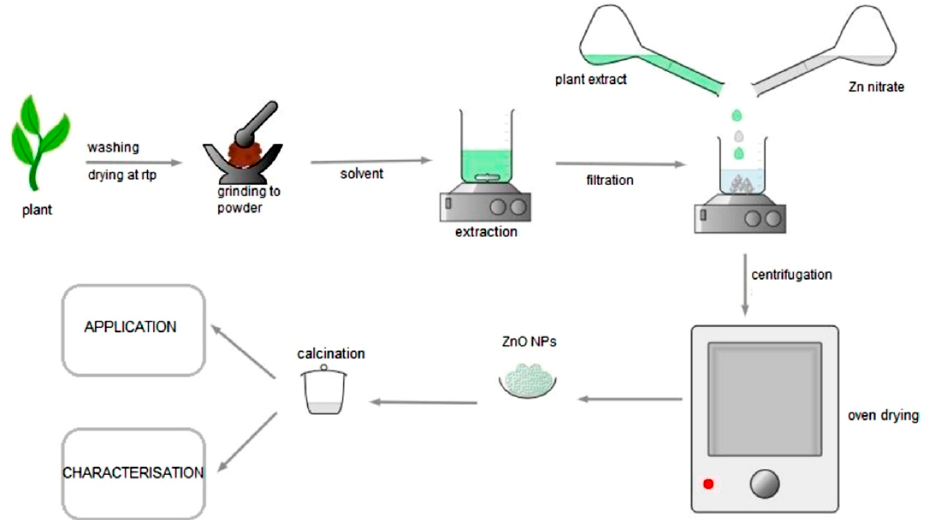
Figure 3. Schematic of the most common ZnO-NPs synthesis procedure [14]. Table 1. Microorganisms-mediated synthesis of